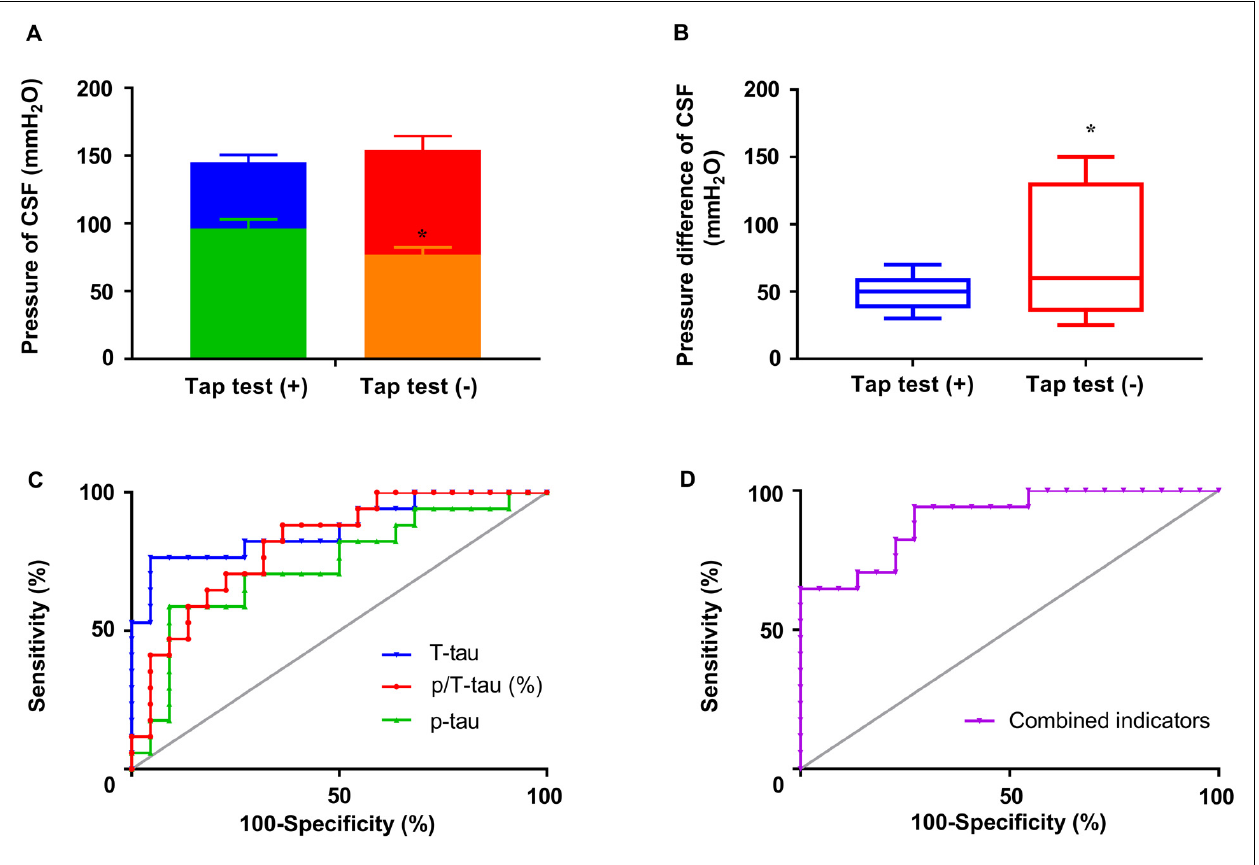
FIGURE 5 | The responsiveness to the tap test and its correlated factors. (A) The differences in the initial and end pressure of CSF in patients with differences in tap test responsiveness. (B) The pressure difference in CSF in patients with differences in tap test responsiveness. (C) ROC curves of T -tau, 181 p -tau, and 181 p / T -tau levels in assessing tap test responsiveness. (D) ROC curves of combined indicators ( − 5.505 + 0.553 ∗ percentage of p/ T -tau − 1.586 ∗ numbers of combined symptoms) in assessing tap test responsiveness (* p < 0.05 compared with the corresponding group. The data in (B) are presented as the medians with interquartile